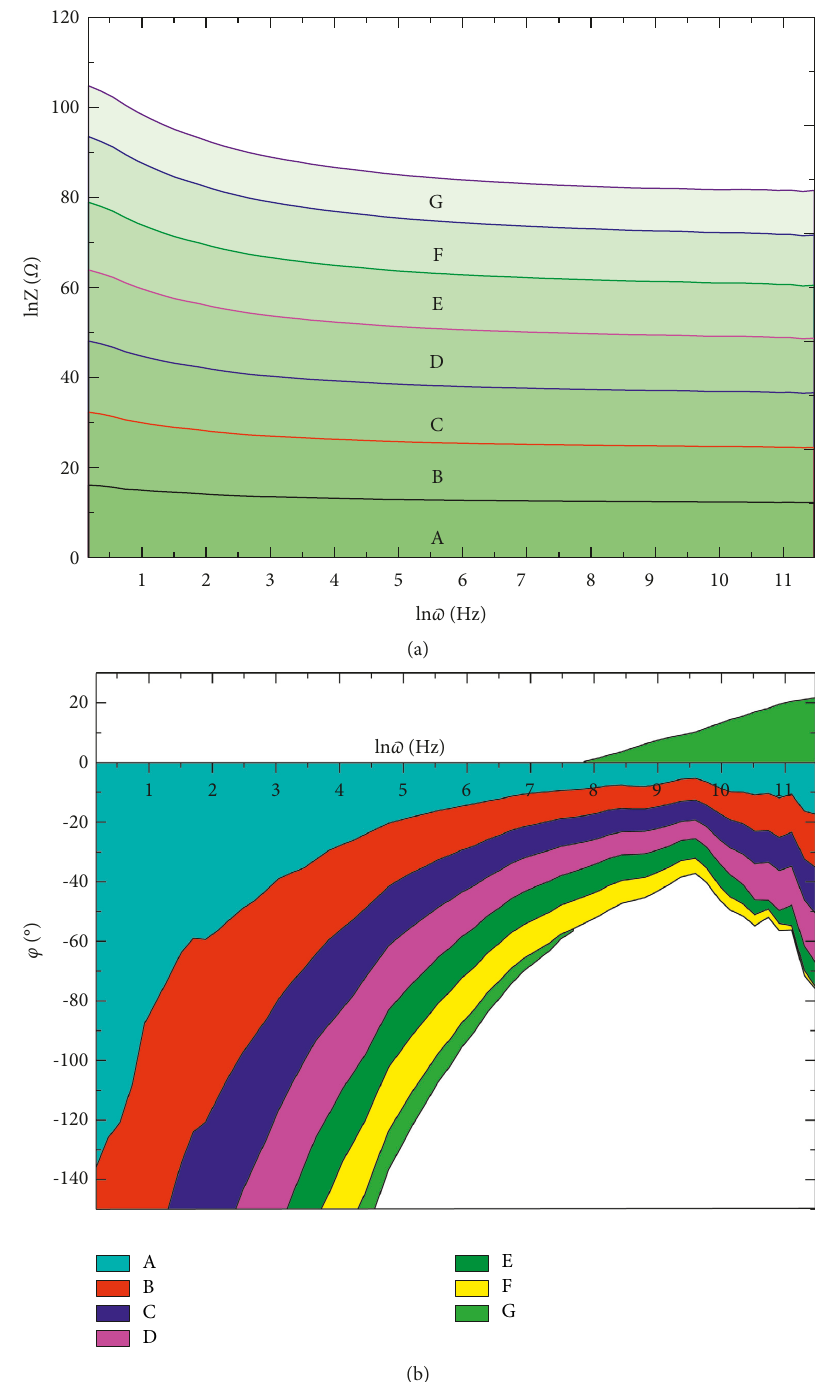
Figure 5: Bode diagram of anchor specimen GD. (a) Area stack diagram of impedance change. (b) Area stack diagram of phase